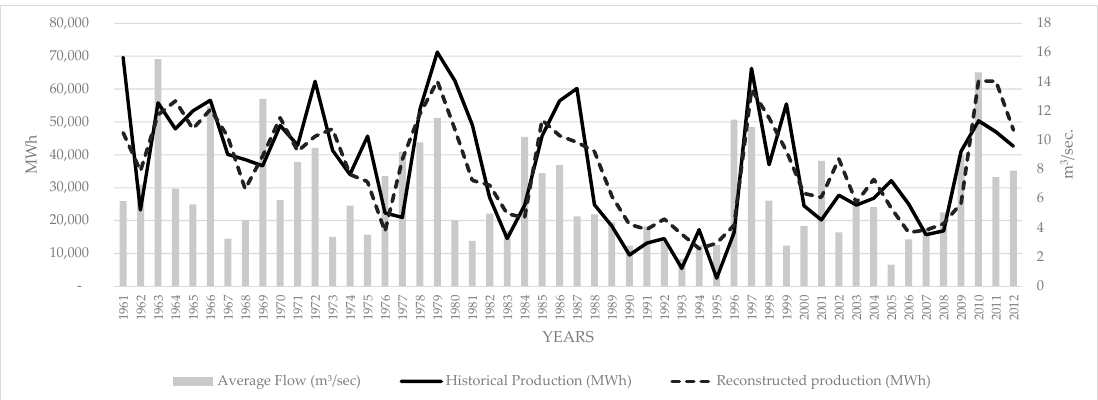
Figure 5. Historical production and reconstruction at the Tranco de Beas plant. Source: Own elaboration and ENDESA.